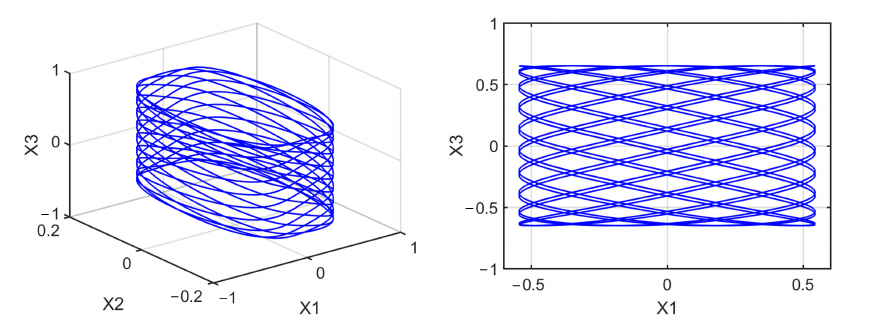
Figure A23. Periodic-19 motion of σ 1 = 6.0491.